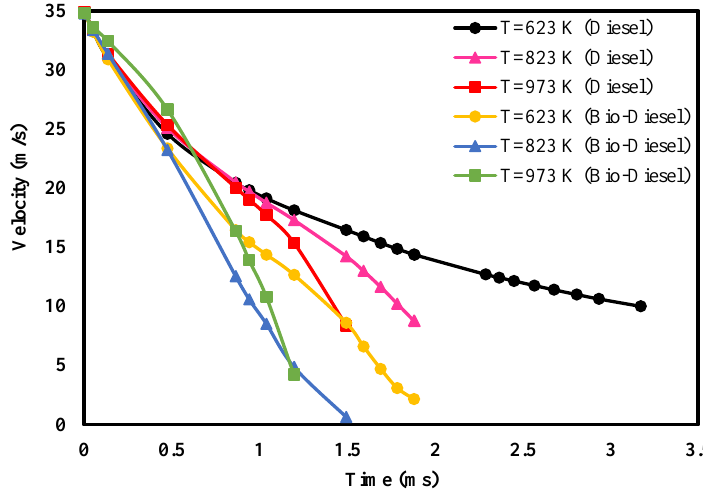
Figure 9. Variation in velocity of 25-micron droplet at different ambient temperatures.